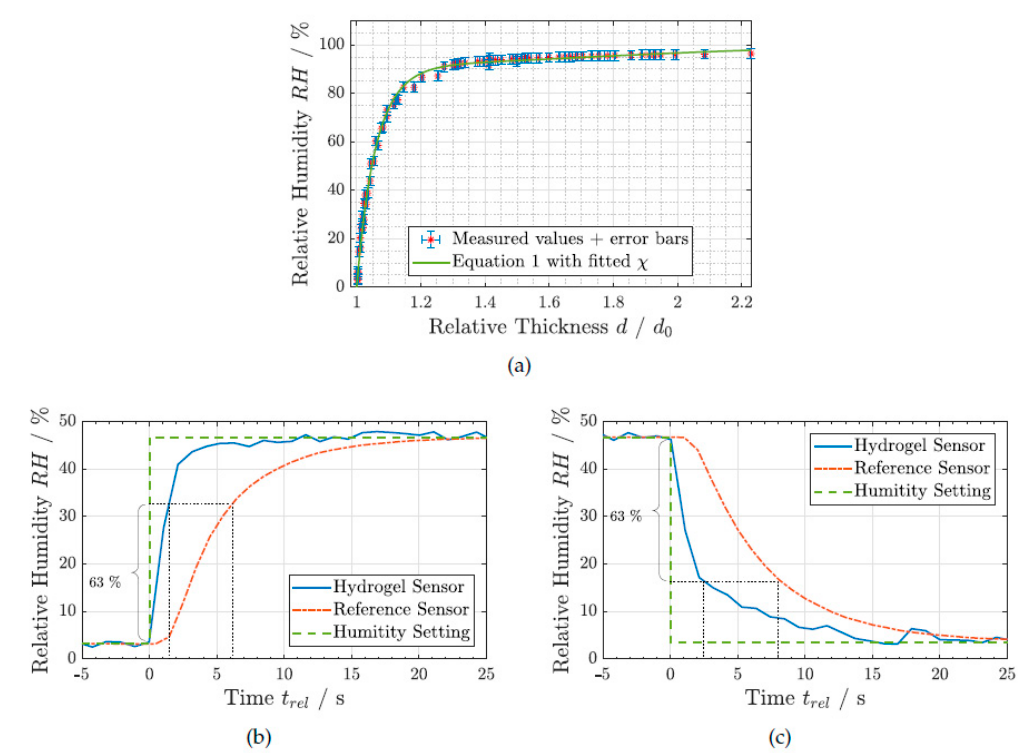
Figure 3. ( a ) RH calculated with Equation (1) as a function of the thickness ratio d / d 0 in comparison with measured data points and response signals of the hydrogel sensor compared to a commercial reference sensor after an abrupt change of the humidity setting for: ( b ) a humidity rise and ( c ) a humidity drop. The dotted lines indicate the response time parameter τ 63